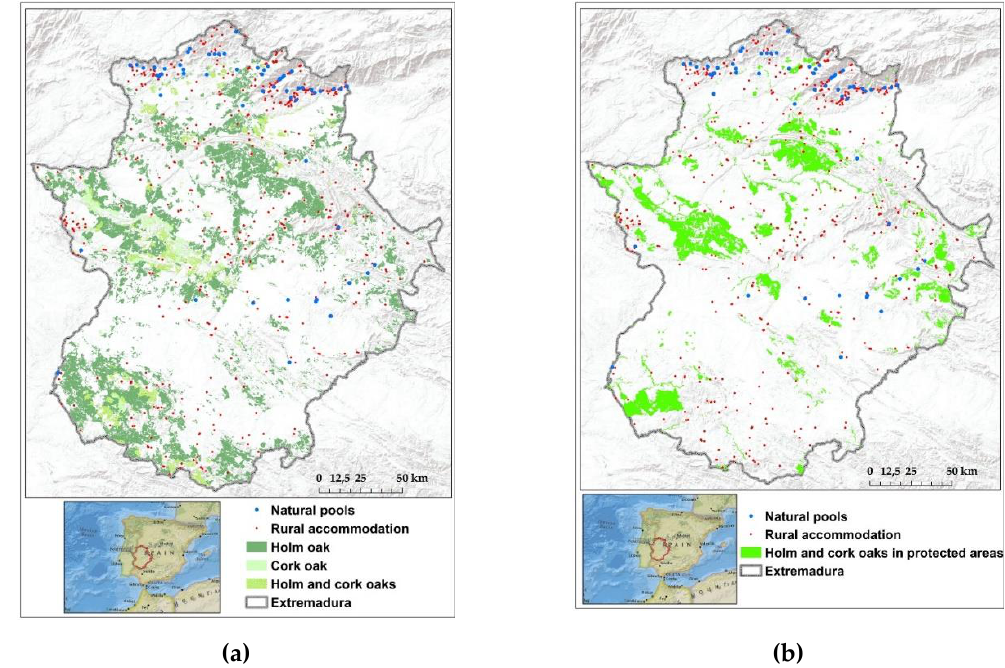
Figure 4. Location of dehesas of holm oaks and cork oaks (a) and protected natural spaces on dehesas (b).